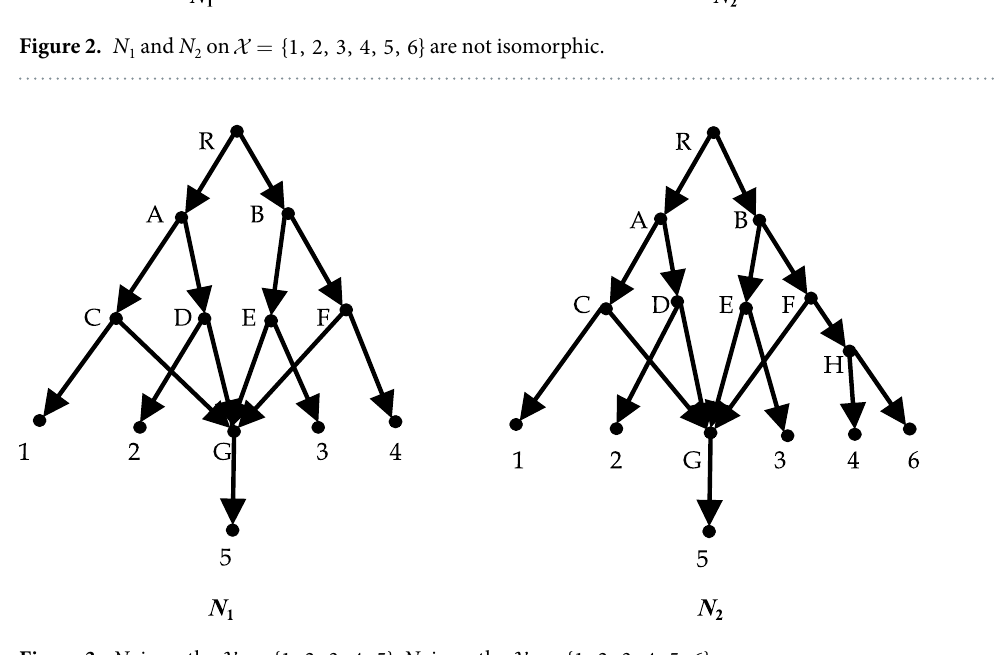
Figure 3. N 1 is on